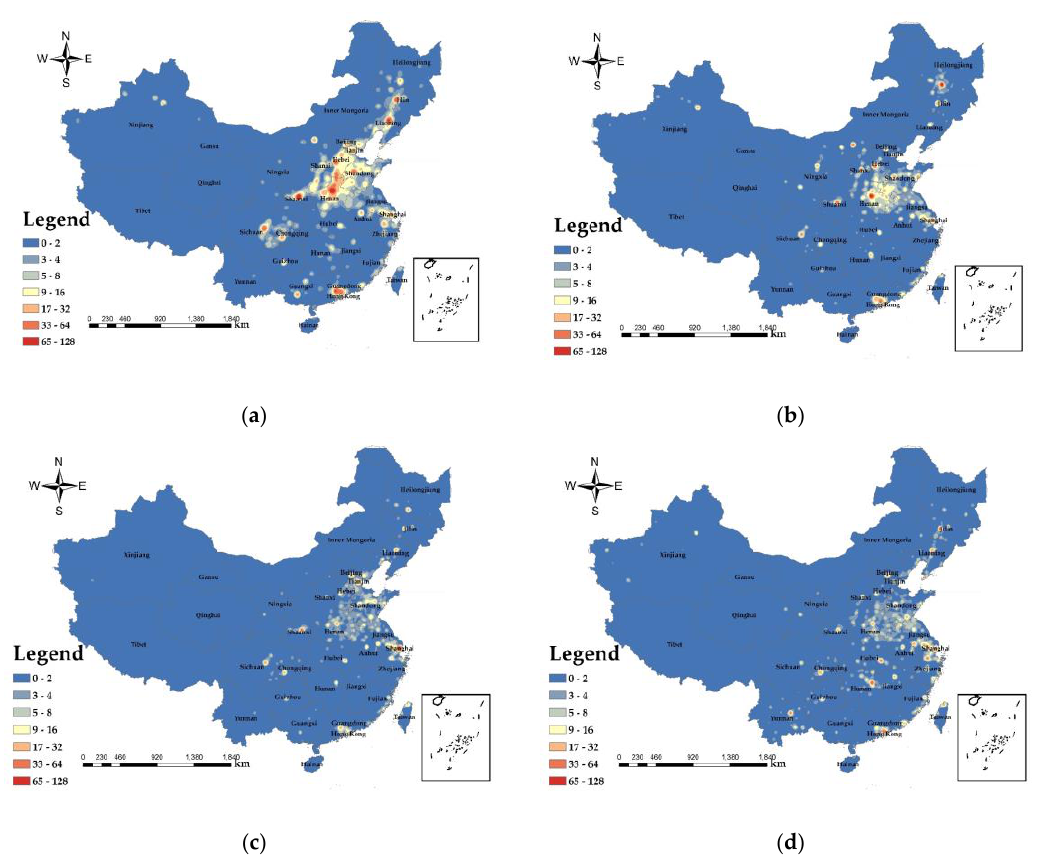
Figure 7. PM 2.5 exposure assessment value ( a ) 25 December 2019; ( b ) 11 January 2020; ( c ) 7